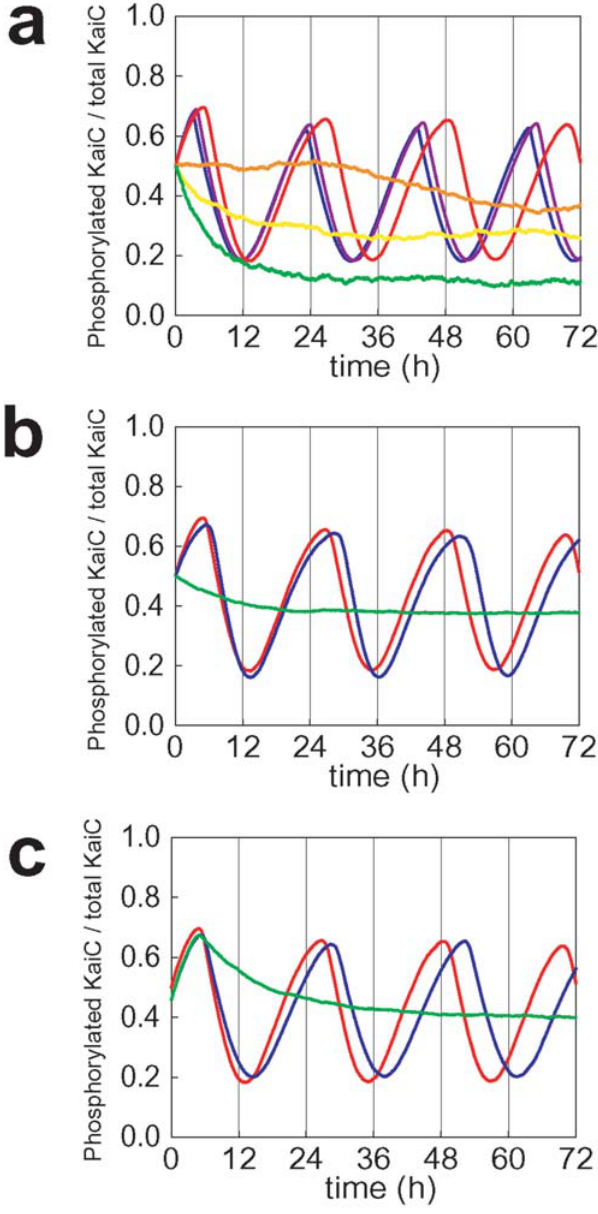
Figure 5. Concentration dependence of the simulated time course of KaiC phosphorylation level, p(t). (a) p ( t ) for the standard mixture (red) and p ( t ) calculated with the concentrations of KaiA, KaiB, and KaiC increased 2.5-fold (blue), 5-fold (purple) or decreased to 1/10 (orange), 1/20 (yellow), and 1/40 (green) of their standard values. (b) p ( t ) calculated with the KaiA concentration decreased to 2/3 (blue) or 1/4 (green) of its standard value (red). (c) p ( t ) calculated with the KaiB concentration decreased to 2/3 (blue) or 1/3 (green) of its standard value (red).